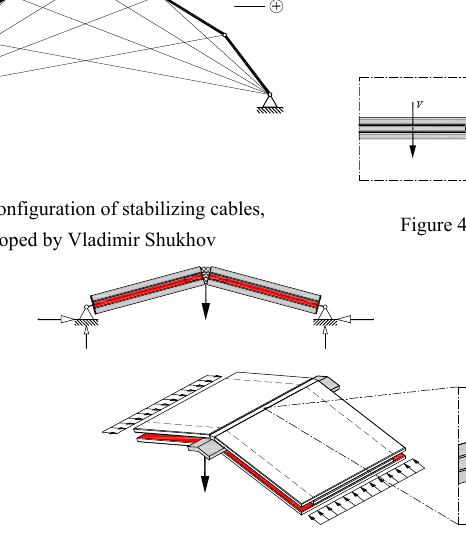
Figure 5: Normal forces in glass panes due to vertical forces on the steel